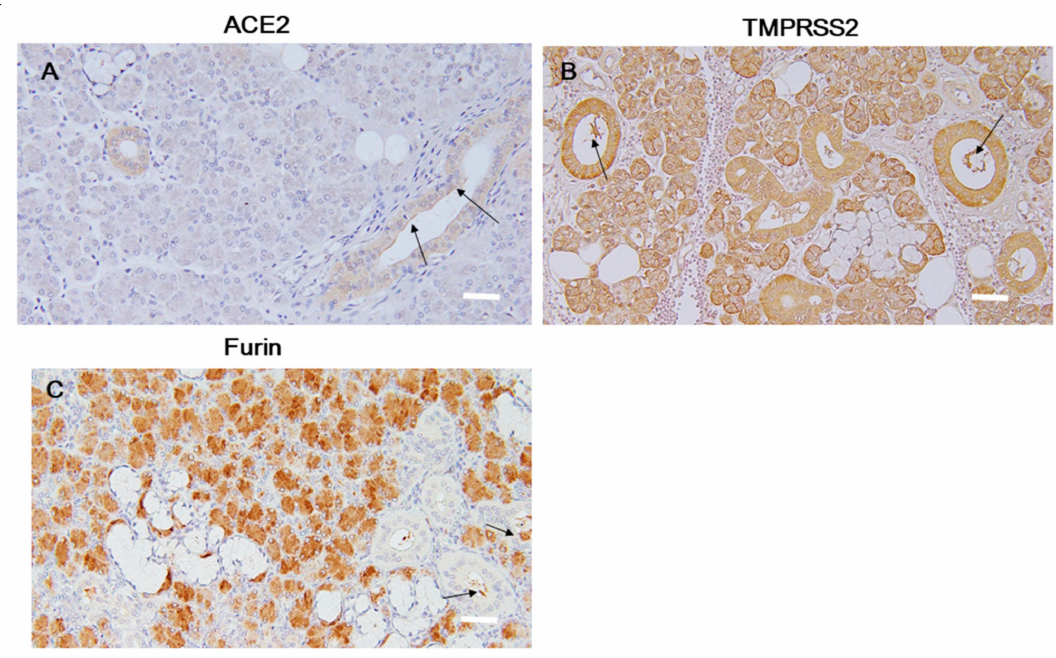
Figure 4. The submandibular gland. Immunohistochemical expression of ACE2 ( A ), TMPRSS2 ( B ), and furin ( C ). The arrows indicate a strong immunochemical positive signal. Scale bar = 100 µ m. ACE2, angiotensin-converting enzyme 2; TMPRSS2, transmembrane protease serine